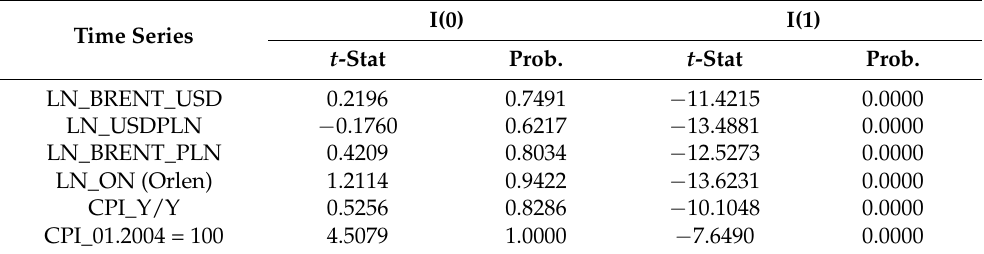
Table 3. Stationarity tests.